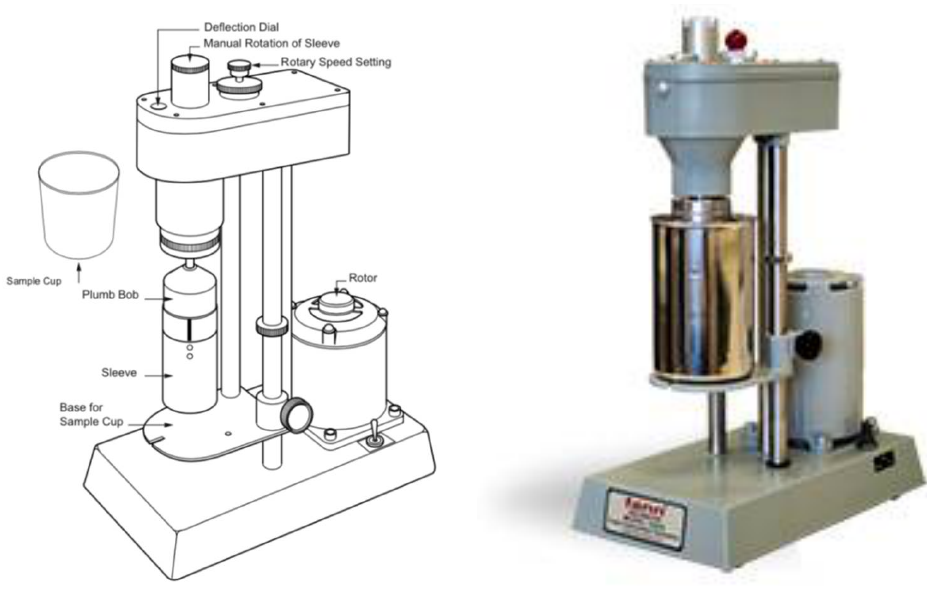
Figure 2. Fann rotary viscometer.